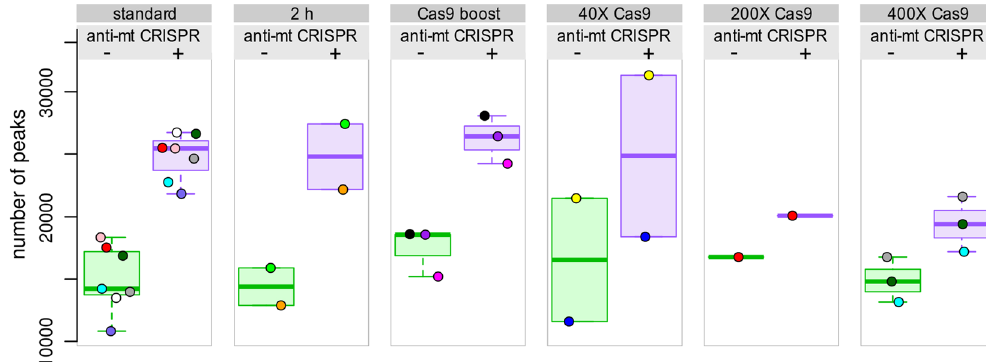
Figure 6. Modifications of the anti-mt CRISPR treatment. Compared to the treatment shown in Fig. 1 (100X gRNA, 100X Cas9, 1 h incubation), labeled “standard”, modifications in the treatment did not show improvement. The number of peaks is comparable or even lower in the modified treatments, compared to the standard treatment. Due to the low number of reads in 6 samples, the results presented were obtained with 9.8 M reads randomly sampled. See also Supplemental Fig.